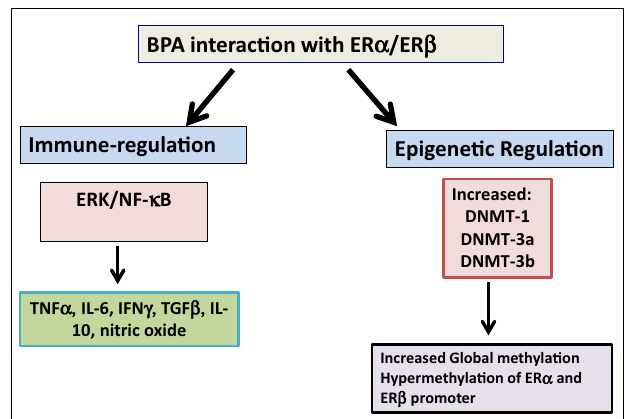
FIGURE 1 | Bisphenol A interaction with estrogen receptors . Bisphenol A (BPA) interacts with estrogen receptor (ER)- α and β to regulate different proinflammatory cytokines such as TNF α , IL-6, and IFN γ and anti-inflammatory cytokines TGF β and IL-10. In addition, it upregulates DNA methyl transferase enzymes (DNMTs) to epigenetically regulate gene expression. Abbreviation: IL: interleukin; ERK: extracellular signal-regulated